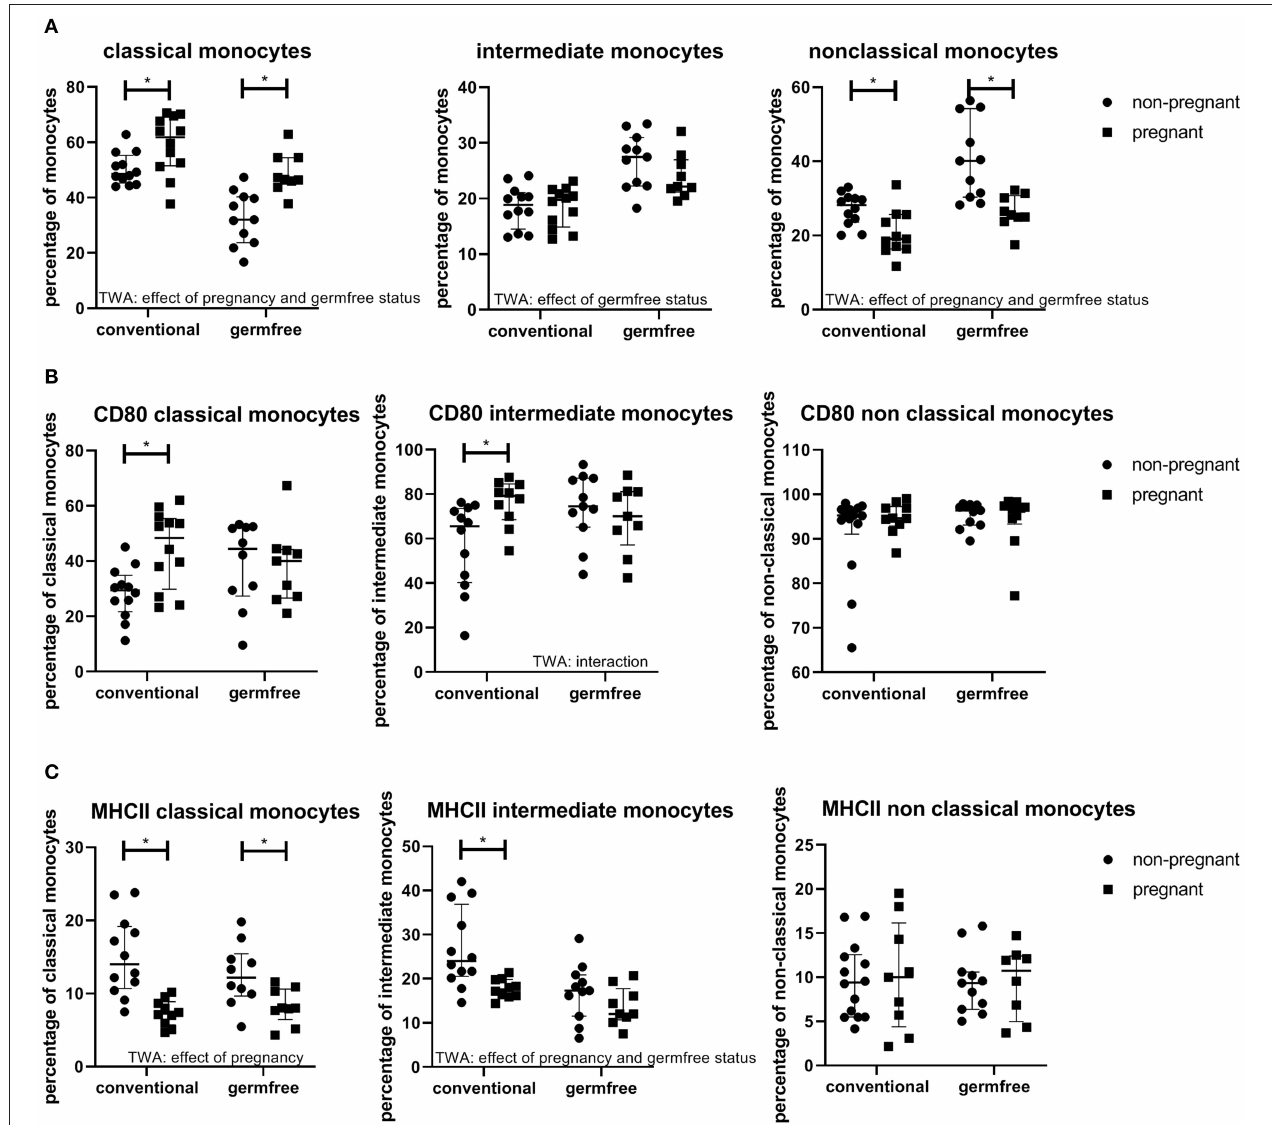
FIGURE 8 | (A) Percentages of monocyte subsets (within the monocyte population) in blood of conventional and germfree pregnant and non-pregnant mice. TWA, Two-way ANOVA. *Significantly different from non-pregnant mice (TWA followed by Fisher’s LSD post-test, p < 0.05). (B) Percentage CD80 positive classical, intermediate and non-classical monocytes in pregnant and non-pregnant conventional and germfree mice. TWA, Two-way ANOVA. *Significantly different from non-pregnant mice (TWA followed by Fisher’s LSD post-test, p < 0.05). (C) Percentage MHCII positive classical, intermediate and non-classical monocytes in pregnant and non-pregnant conventional and germfree mice. TWA, Two-way ANOVA. *Significantly different from non-pregnant mice (TWA followed by Fisher’s LSD post-test, p <